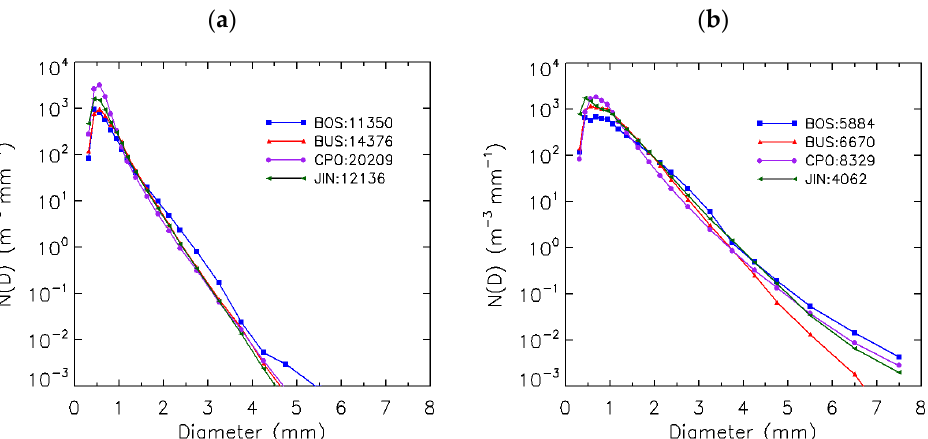
Figure 7. Average number concentrations of diameter with rain types ( a ) stratiform and ( b ) convective rain at the four studied sites. The number in the legend represent the sample number. The rectangles in blue represent BOS, the triangles in red represent BUS, the circles in purple represent CPO, and the arrows in green represent the JIN site. Table 1. The average DSDs variables, rain rates, and sample numbers of rain types at the four stud- ied sites.